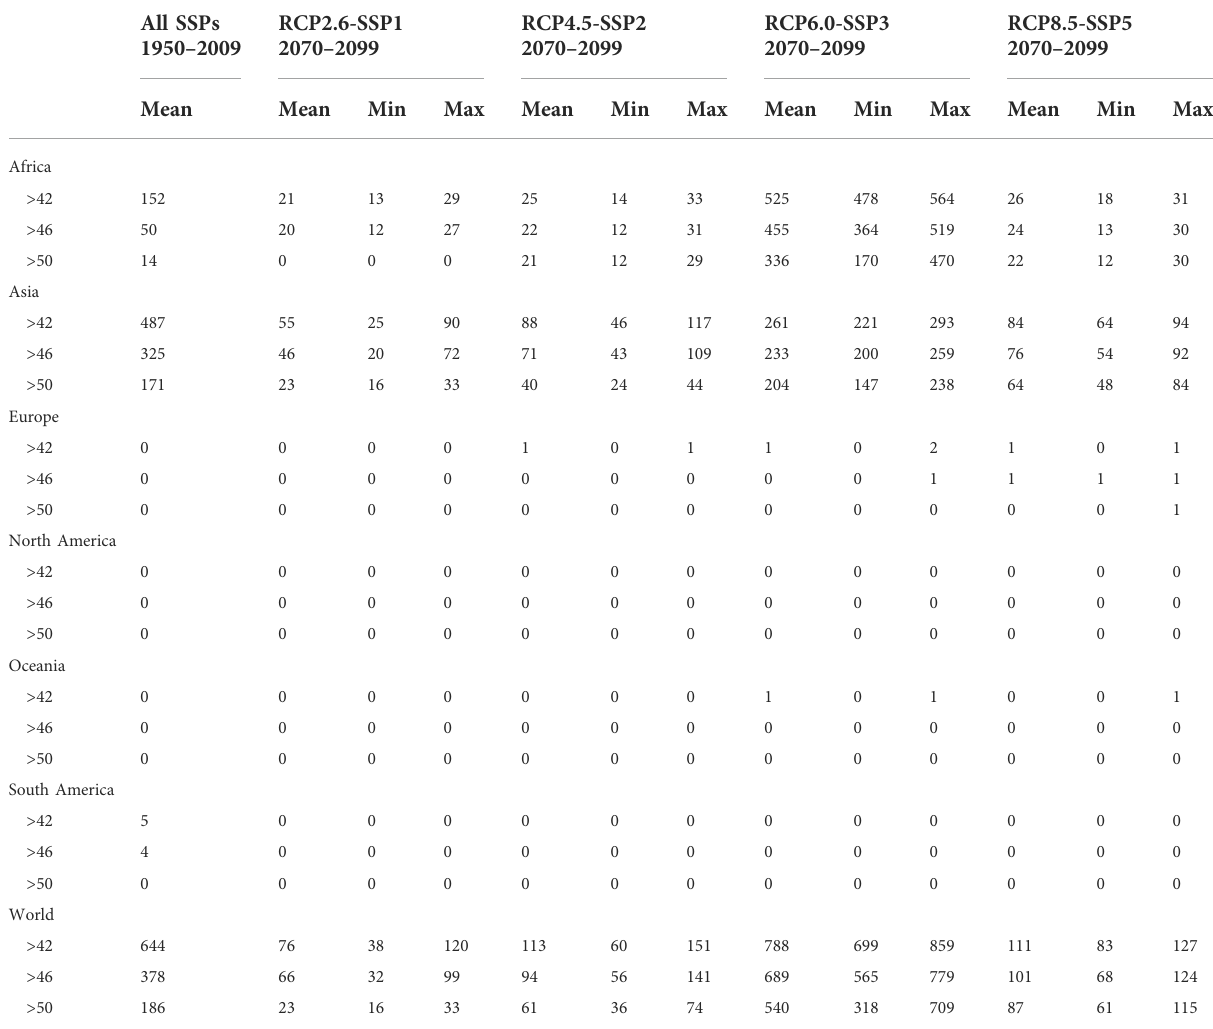
TABLE 6 Urban low-income population exposed to extreme heatwaves by region. This table presents the mean range of urban residents that are considered low-income (national GDP of < $4,000 per capita) projected to be exposed to 15-day heatwaves of > 42 ° C. The data are presented by region and for the